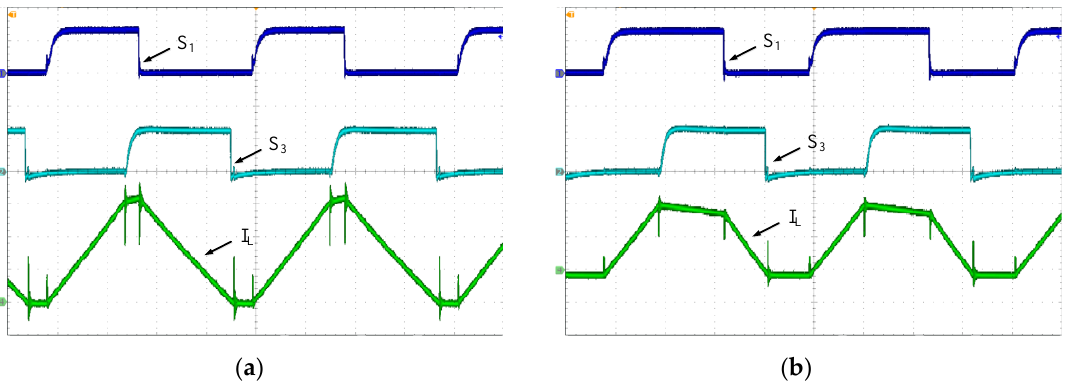
Figure 14. Measured waveforms under charging mode (300 W). ( a ) Buck-charging mode; ( b ) Boost-charging mode.